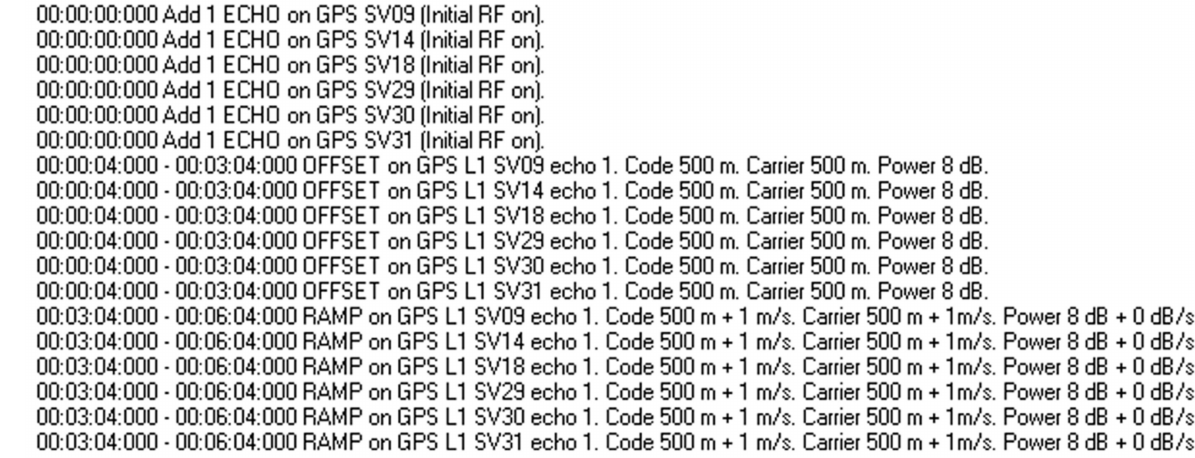
Figure 6. Experimental instruction design in experiment